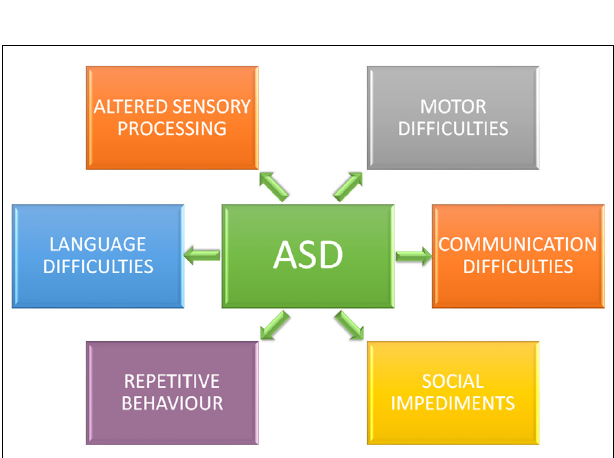
FIGURE 1 | Core symptoms of autism spectrum disorder (ASD). Individuals diagnosticated with ASD present impaired social interaction, delayed and disordered language, repetitive or stereotypic behavior, restricted range of interests, and altered sensory